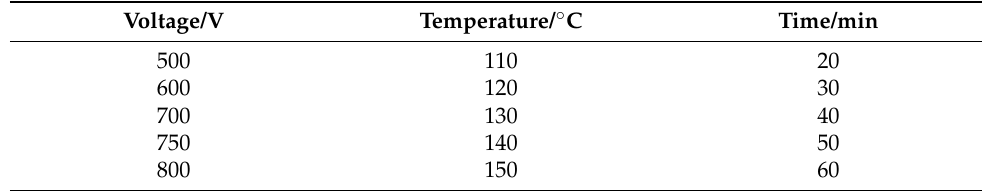
Table 1. Polarization process conditions.